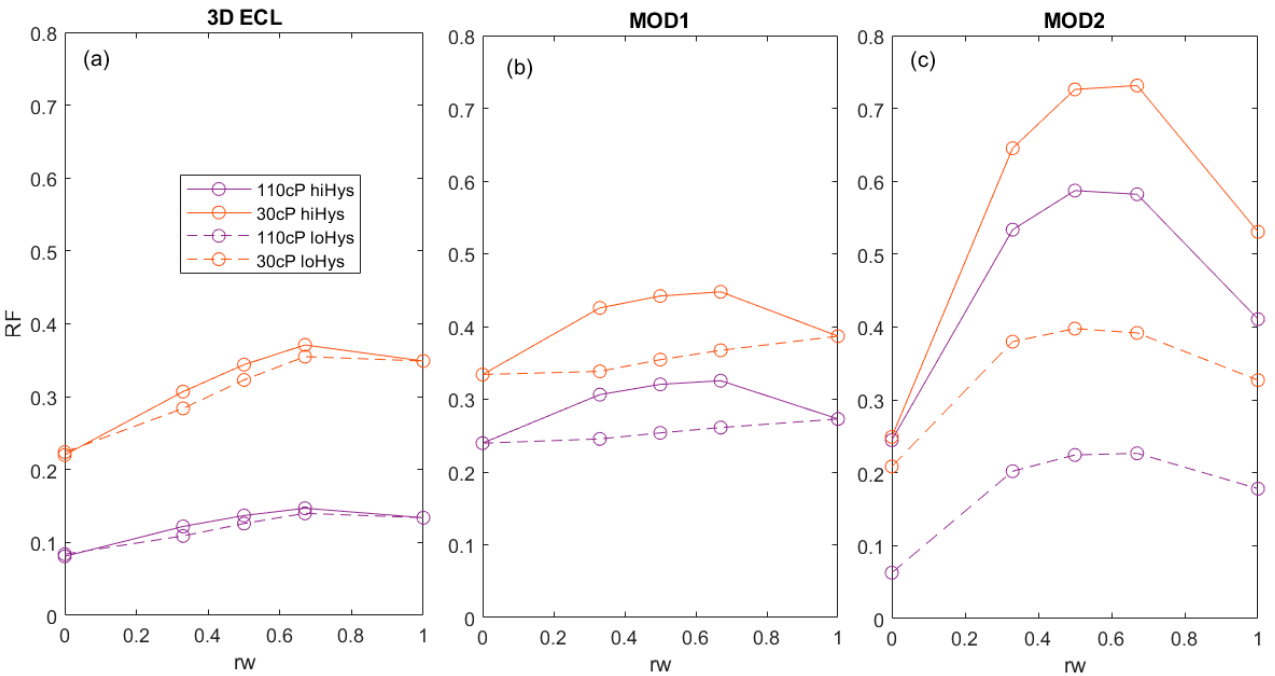
Figure 16. RF after 1.5 PV calculated for different injected WAG fractions ( r w ), low or high oil viscosity and low or high degree of hysteresis, calculated based on a 3D Eclipse model ( a ), MOD1 ( b ) or MOD2 ( c ).